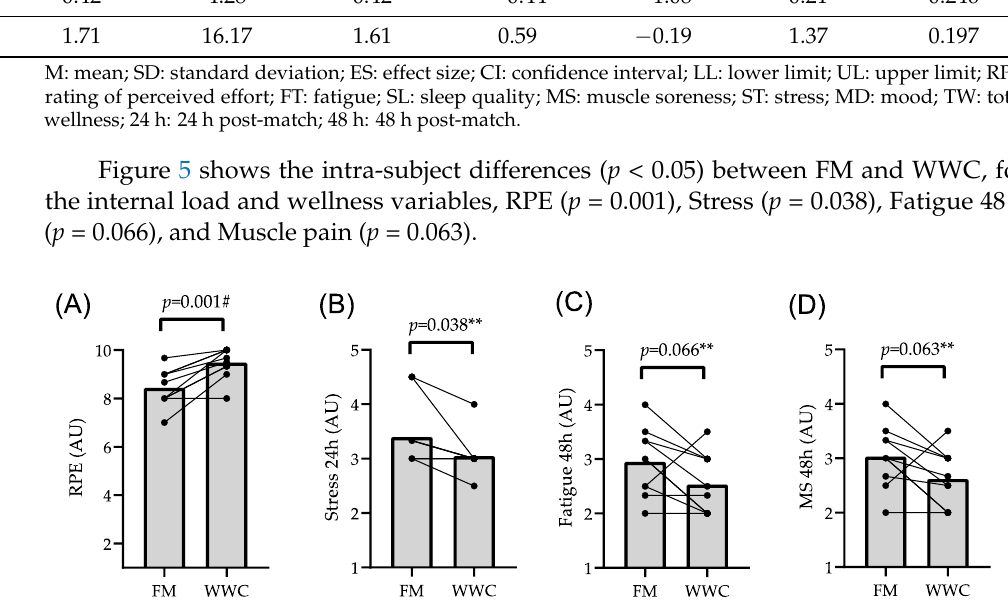
Table 2. Description and comparison of ILO between periods.